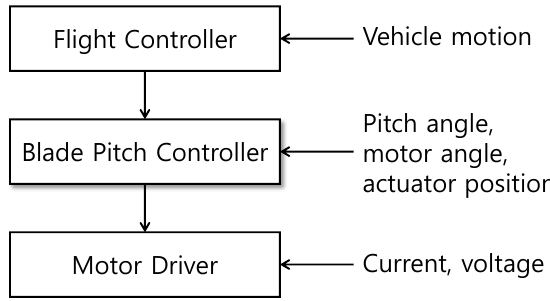
Figure 1. Hierarchical fault detection and tolerance system.